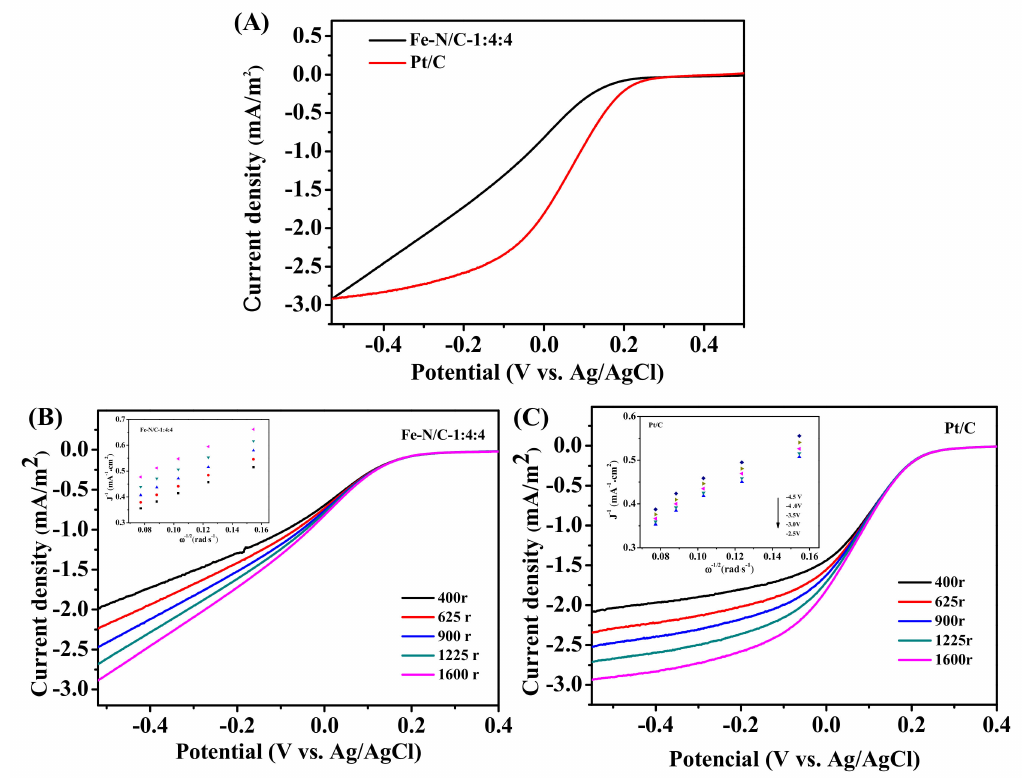
Figure 8. ( A ) The LSV curves of the Fe-N/GNR@CNT-1:4:4 and Pt/C; ( B , C ) The LSV curves of Fe-N/C-1:4:4 and Pt/C at different rotating speeds. Insets: K–L plots.